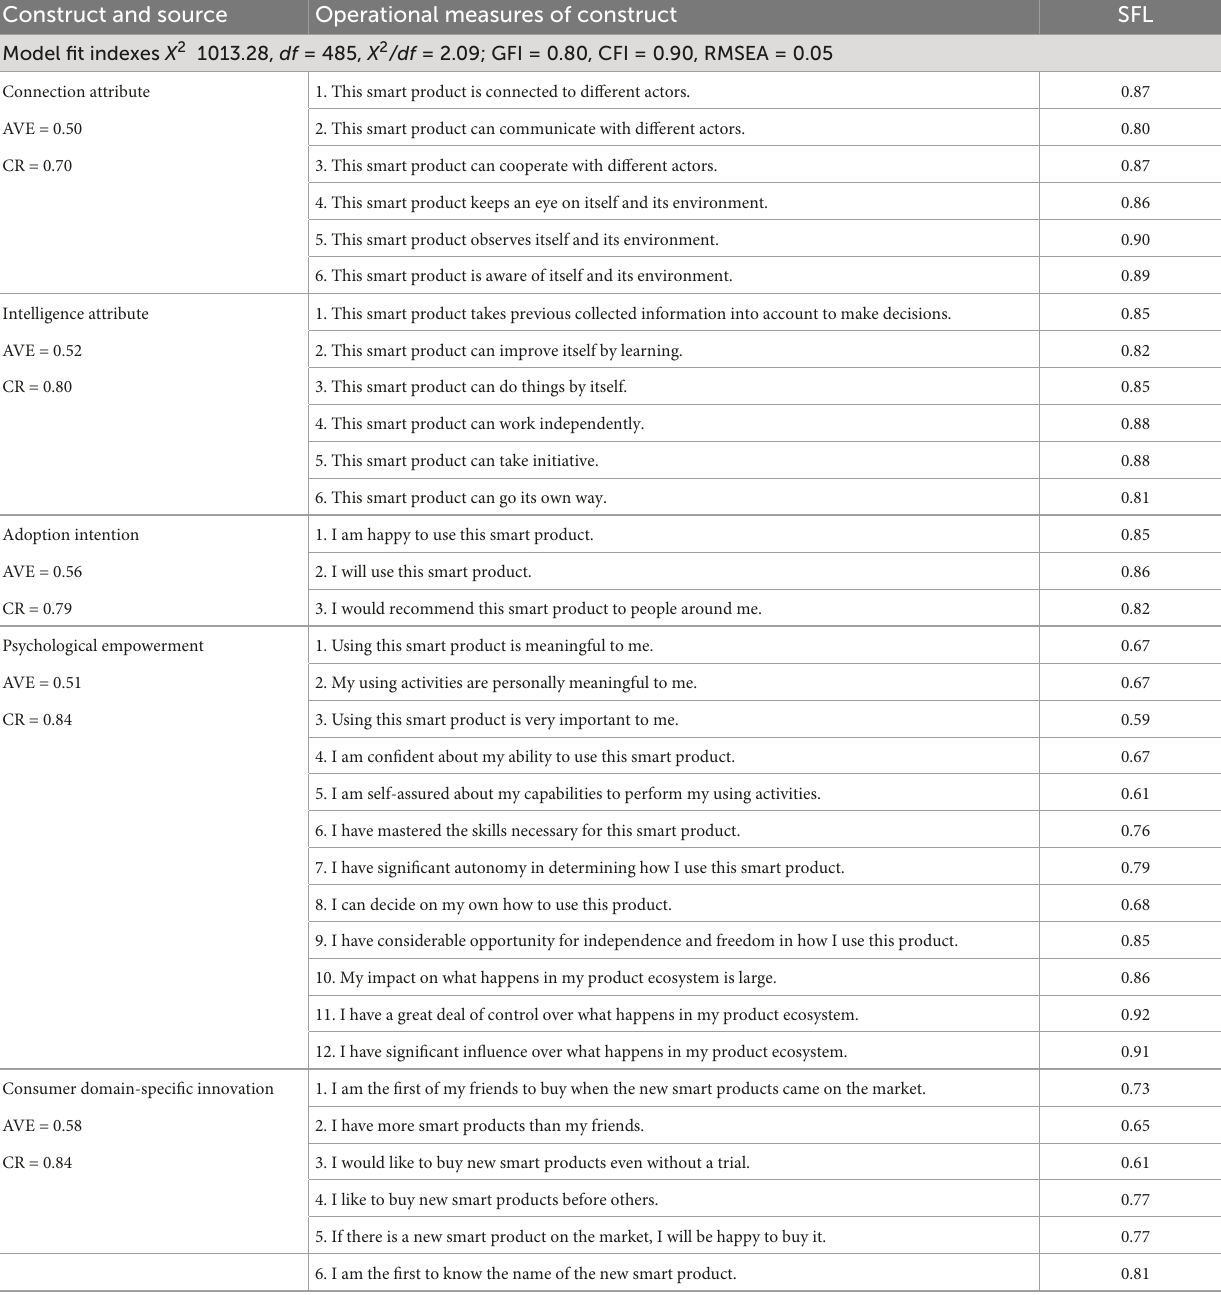
TABLE 1 Confirmatory factor analysis of the measures. Construct and source Operational measures of construct SFL